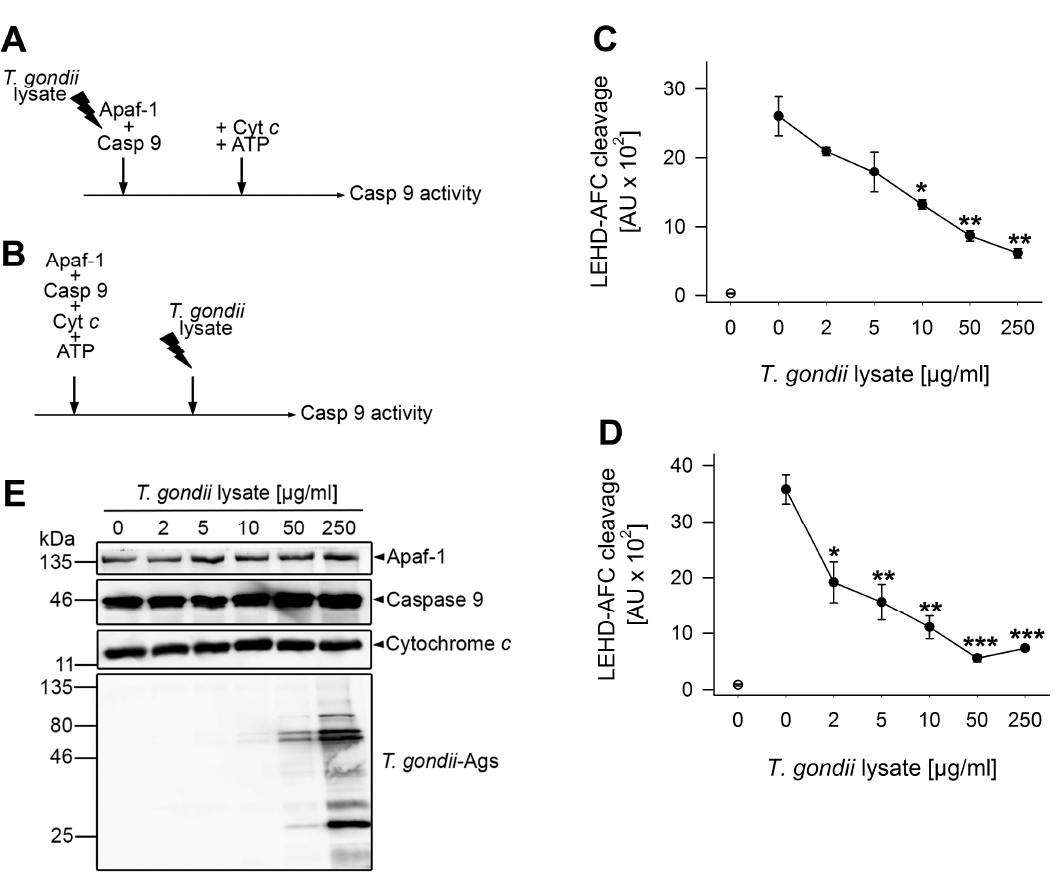
FIGURE 5: T. gondii protein extract dose-dependently diminishes caspase 9 activity triggered by cytochrome c and ATP in a reconstituted in vitro system. (A, C) Recombinant human Apaf-1 and caspase 9 were incubated with increasing amounts of T. gondii protein lysate or were left untreated. After 1 hour, apoptosome formation was triggered by adding cytochrome c and ATP, and 15 minutes later, caspase 9 activity was determined by fluorimetric measurement of LEHD-AFC cleavage. (B, D) Recombinant Apaf-1 and caspase 9 were induced to form apoptosomes using cytochrome c and ATP. After 1 hour, preassembled apoptosomes were incubated with increasing amounts of T. gondii protein extract for 45 minutes. Fifteen minutes later, caspase 9 activity was fluorimetrically measured as above. (C, D) Data represent the increase in substrate cleavage over time from samples as described in (A, B); results are expressed as means ± S.E.M. (n = 3). Background activity in samples without cytochrome c /ATP is indicated by an open circle. Significant differences between activated samples without T. gondii proteins and those incubated with T. gondii proteins have been identified by Student’s t -test (* P < 0.05; ** P < 0.01; *** P < 0.001). (E) Recombinant and/or purified components were incubated with increasing amounts of T. gondii lysate according to the protocol depicted in (A) but without adding ATP. After SDS-PAGE and Western blotting, proteins were analyzed by immunostaining using specific antibodies as indicated and peroxidase-conjugated secondary antibodies. Immune complexes were visualized by enhanced chemiluminescence. Results are representative for two